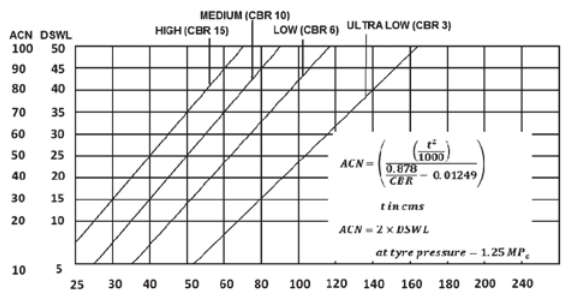
Fig. 3. ACN flexible pavement conversion